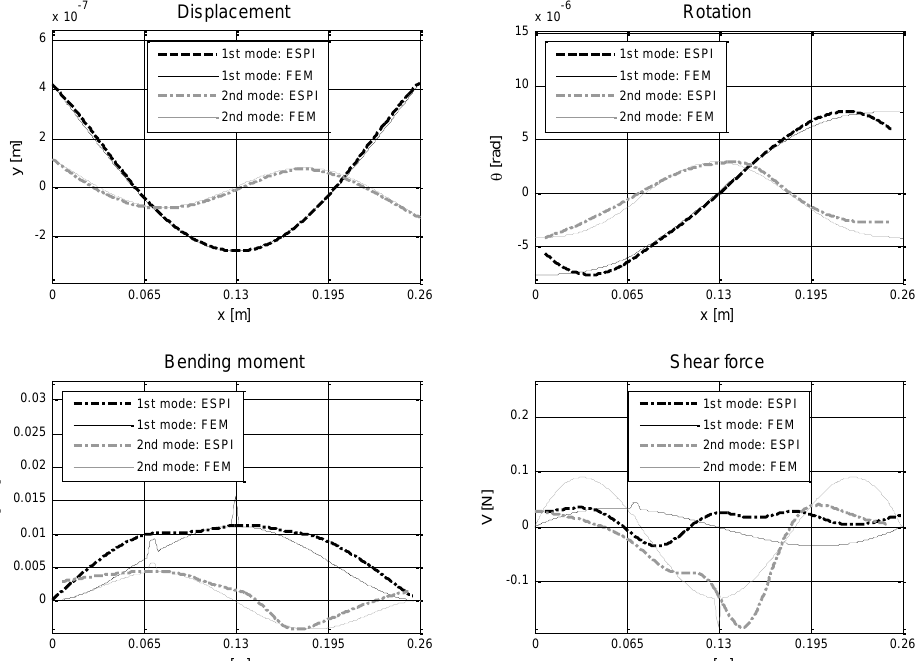
Fig. 3. Displacement and rotation fields, bending moments and shear force distributions of damaged beam using the pulsed ESPI system (ESPI) and the finite element method (FEM) for the fourth damage case.